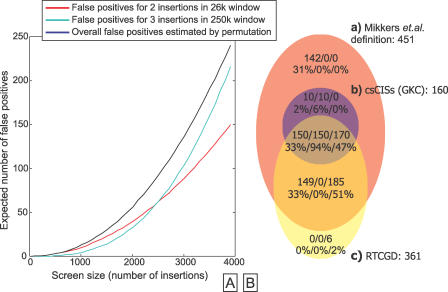
Comparison with Previous CIS Definition(A) Plot of the increase of the error as a function of the screen size, when using the definition from [8], computed using the Poisson distribution, or a permutation approach. Also the results from the two individual windows used are given. Since the errors made by the two windows individually are not mutually exclusive, the Poisson estimate is an overestimate of the true error.(B) Venn diagram comparing three different CIS definitions: a) the definition from [8] applied to the complete dataset, b) the csCISs resulting from the GKC, and c) the published CISs from the RTCGD. The intersection between sets shows three counts (and corresponding percentages), indicating the count for set a, b, and c, respectively. This is because the three sets of CISs used different definitions (at different scales) for a CIS, so that some CISs are split up, and hence are counted twice.